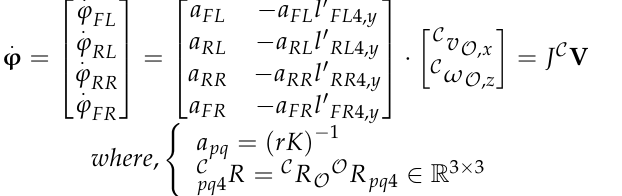
aged as follow Equation(12).